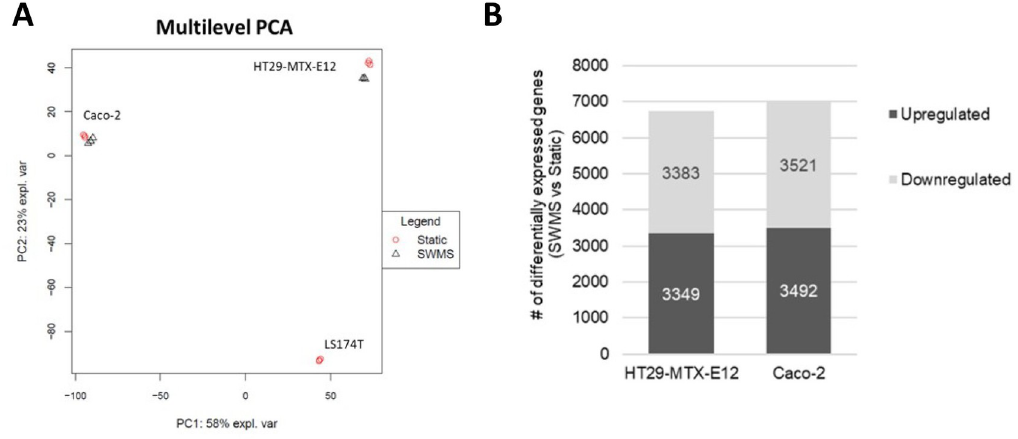
Fig 1. Overview microarray results in HT29-MTX-E12, Caco-2 and LS174T cells grown under static and/or SWMS conditions. A) Multilevel principal component analysis (PCA) of the 500 most variable genes. B) Number of differentially expressed genes between SWMS and static conditions in HT29-MTX-E12 and Caco-2 cells (IBMT p < 0.05). Microarray results are based on n = 3 biological replicates per condition.